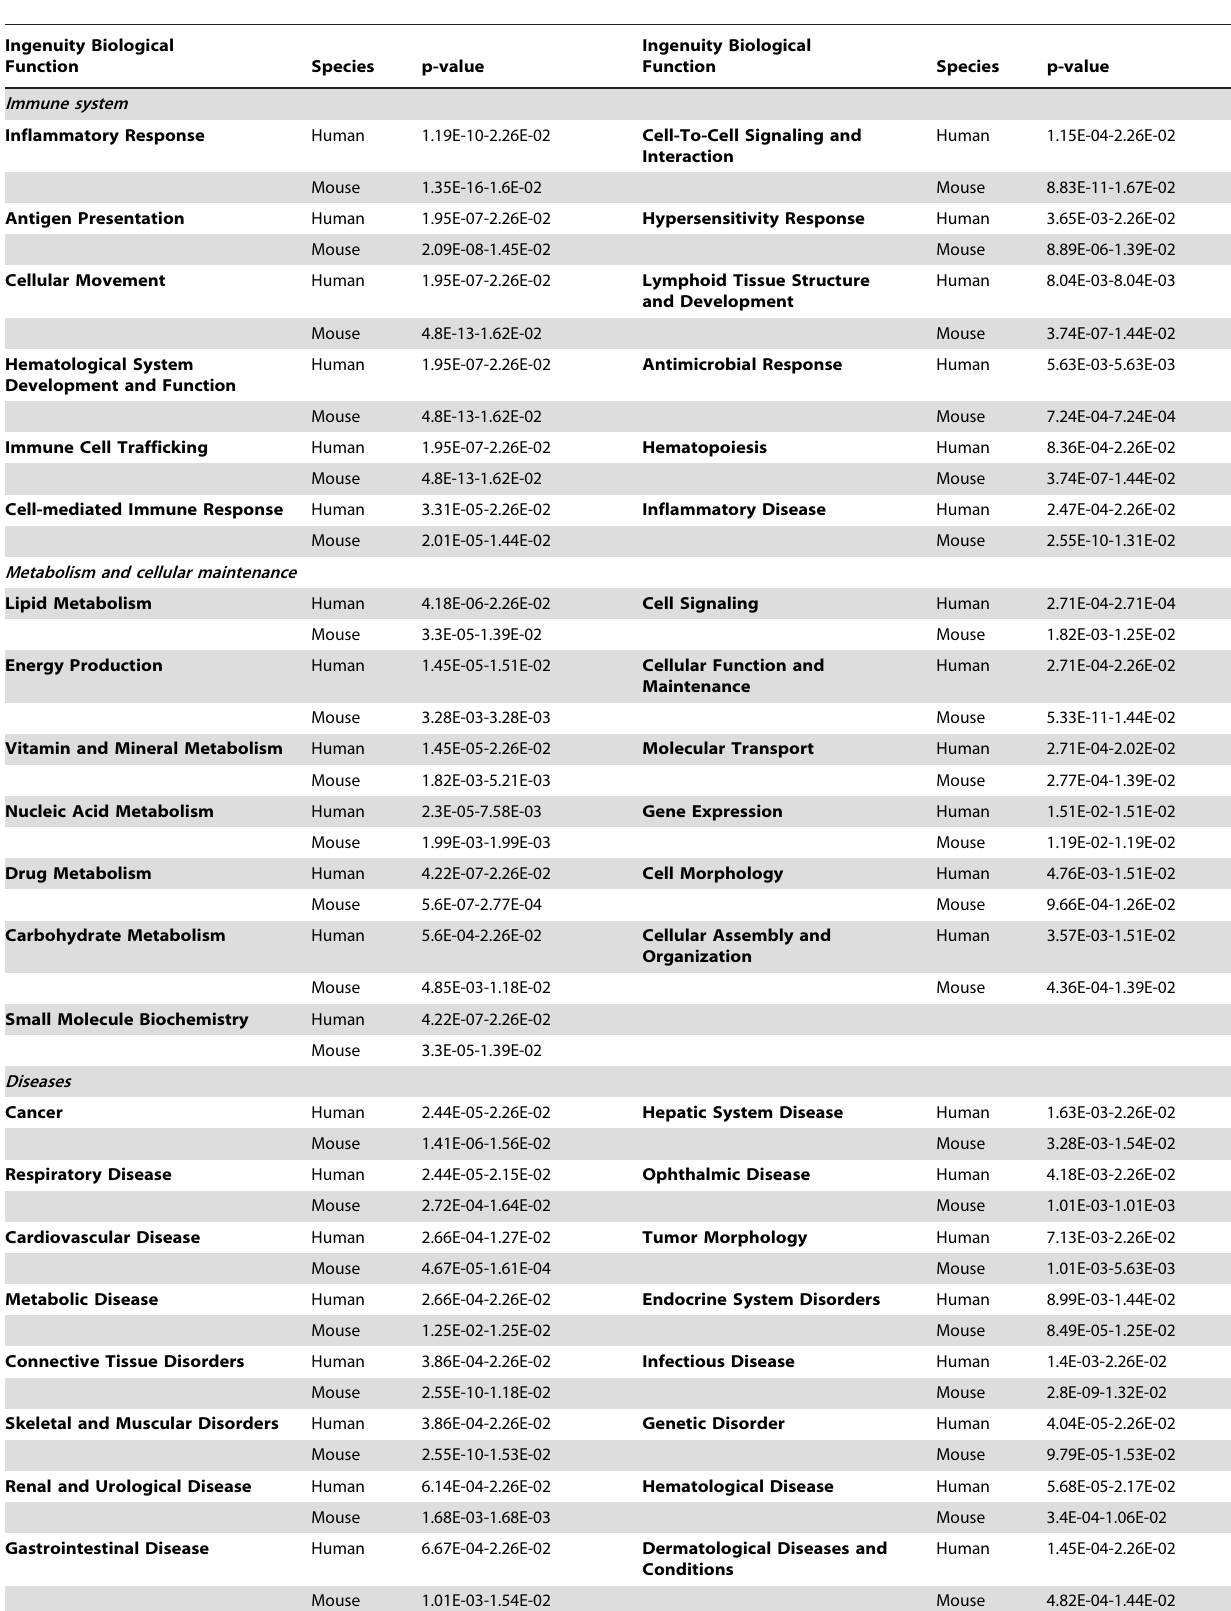
Table 4. Common biological functions altered by cigarette smoke exposure in the human and mouse